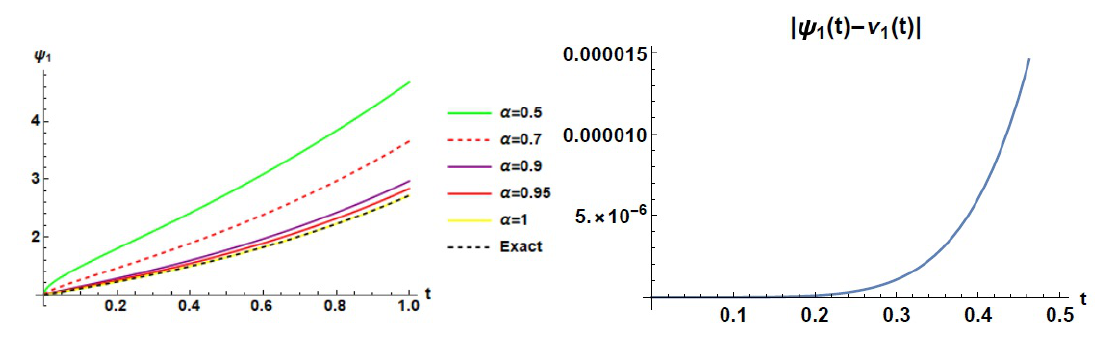
Figure 3: Exact, profile approximate solutions and absolute error regarding ν 1 of Example 2.